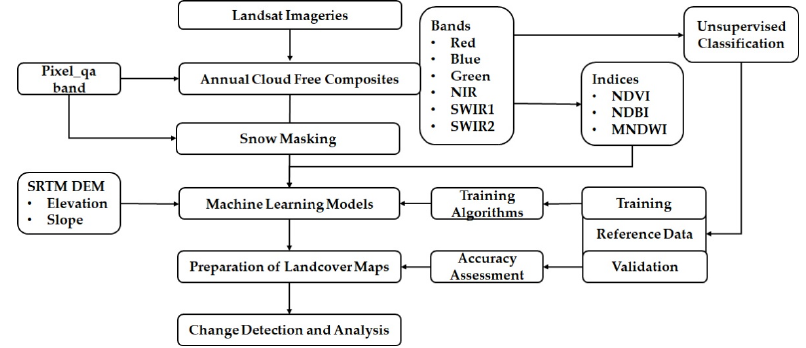
Figure 1. The workflow adopted for the land cover (LC) classification and change detection in this study.